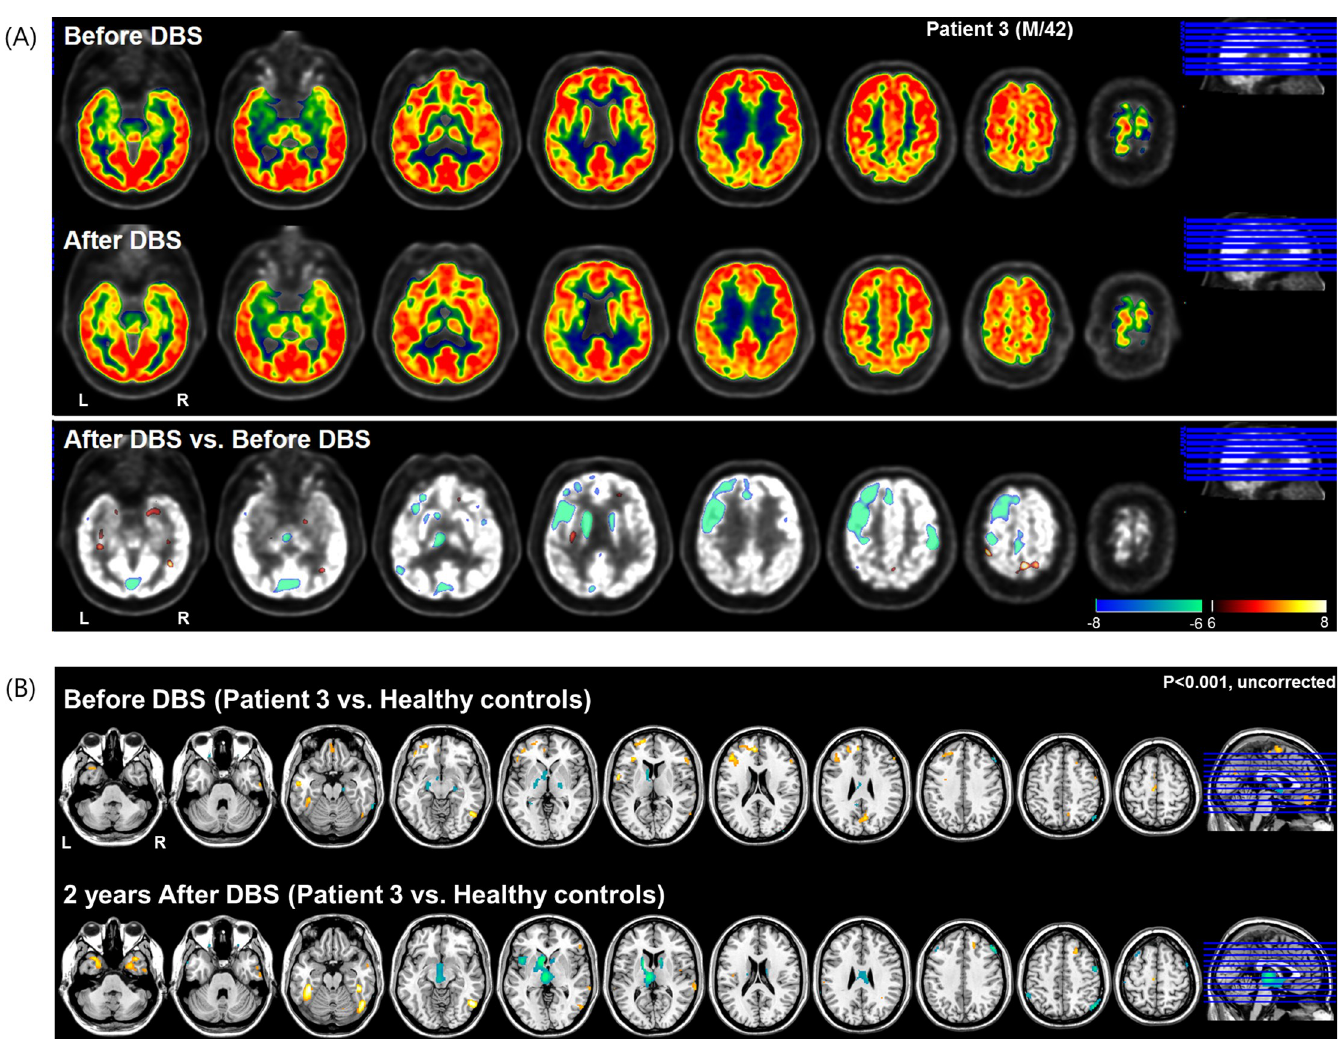
Fig 4. 18 Fluorodeoxyglucose-positron emission tomography (FDG-PET) image taken in Subject three at pre-and postoperative 2 years. (A) Relative to before DBS showed extensively decreased metabolic activity in left frontal including anterior cingulate and bilateral caudate after DBS. (B) This metabolic activity in prefrontal including anterior cingulate regions was hyperactive in before DBS and then at 2 years after DBS, this pattern was recovered or normalized as a normal state (p < 0.001, uncorrected for multiple